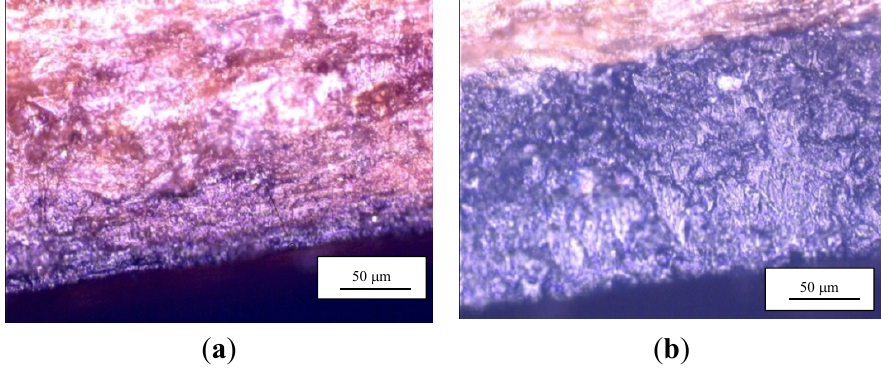
Figure 4. Microscopic analysis of the bonding: ( a ) primer-wood interface; ( b ) saturant-wood interface.